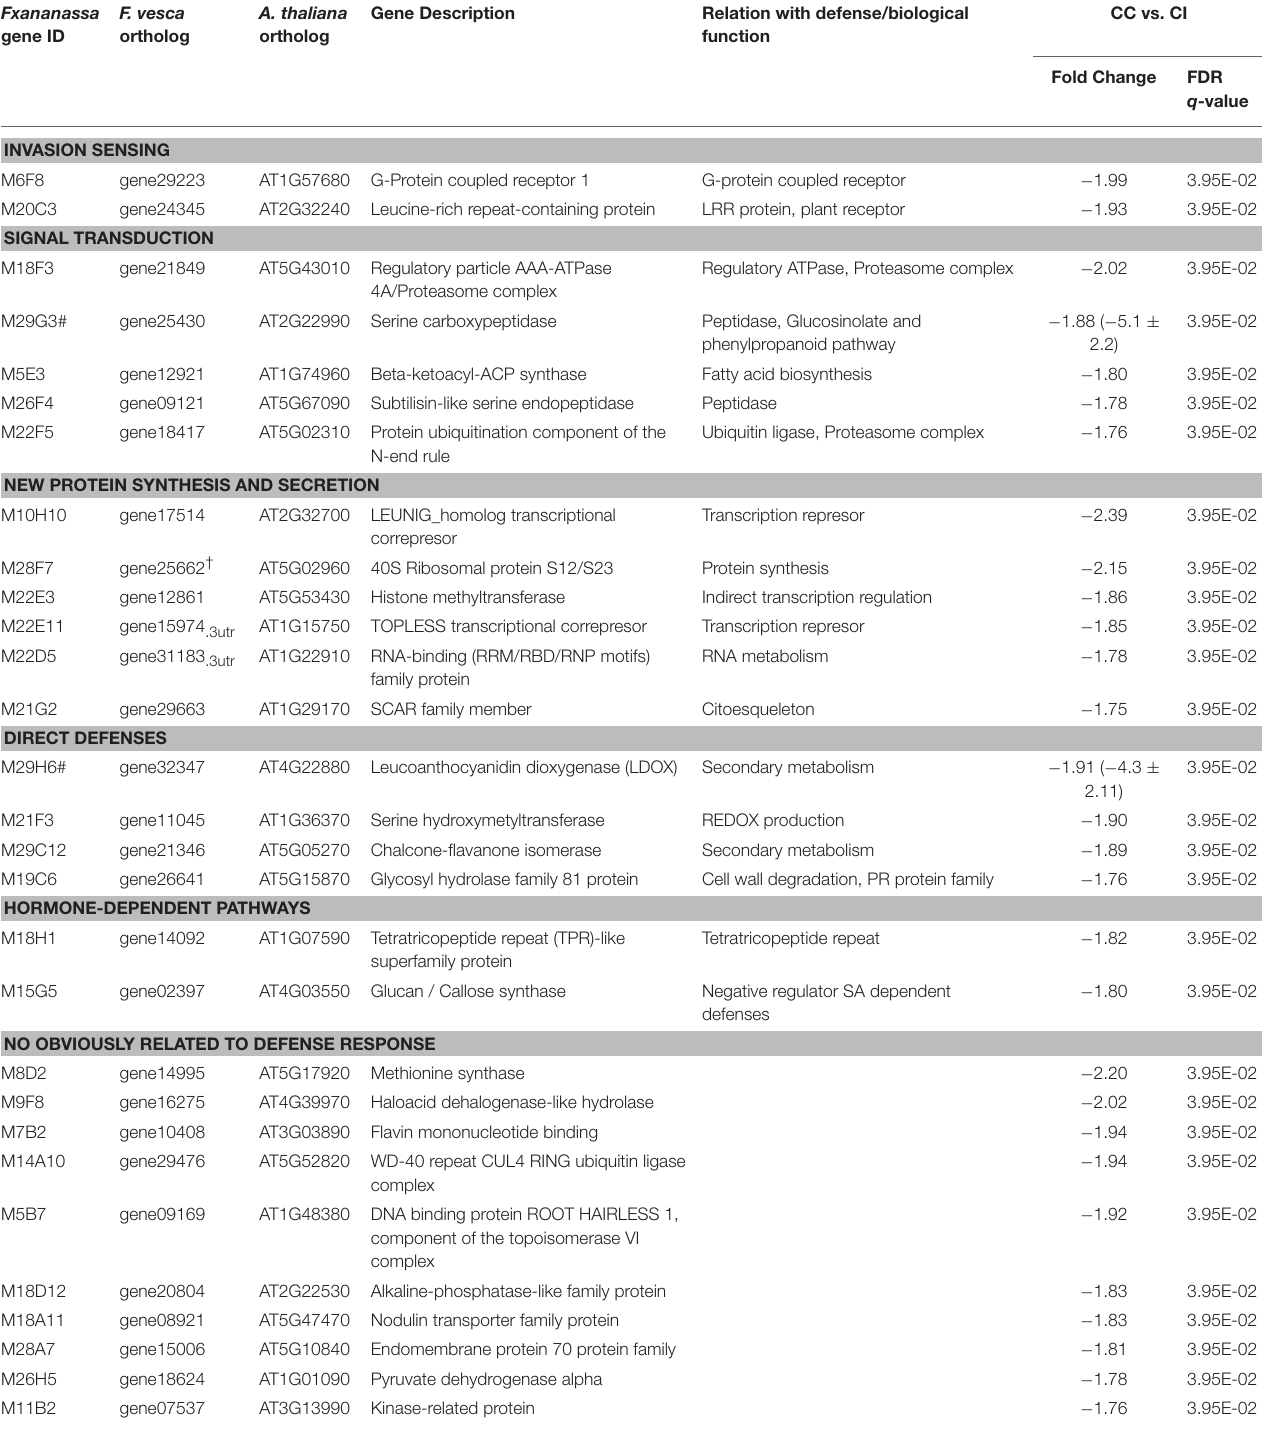
TABLE 1B | Down-regulated genes by Colletotrichum acutatum in crown tissue of Fragaria x ananassa , cultivar